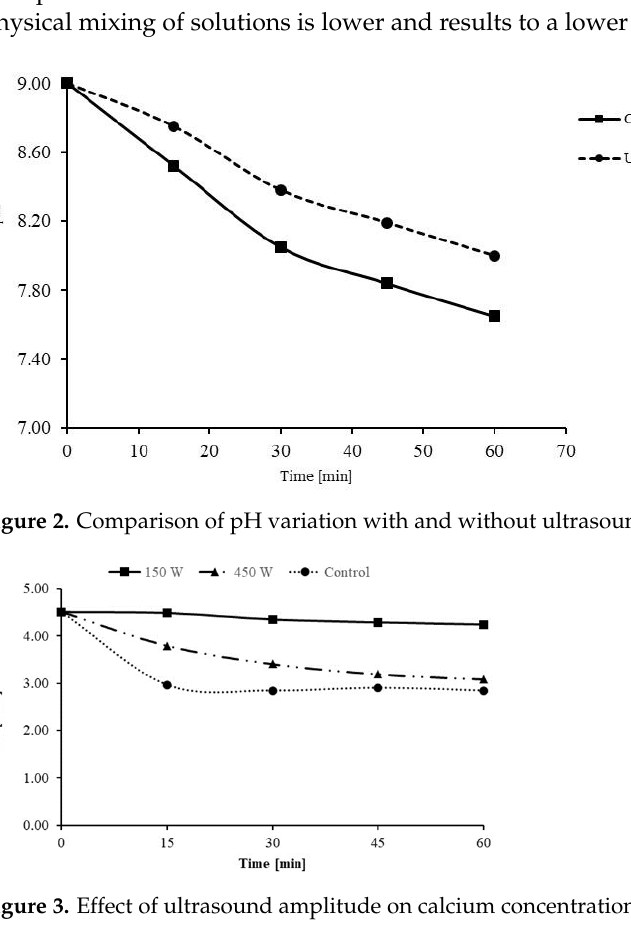
Figure 3. Effect of ultrasound amplitude on calcium concentration.